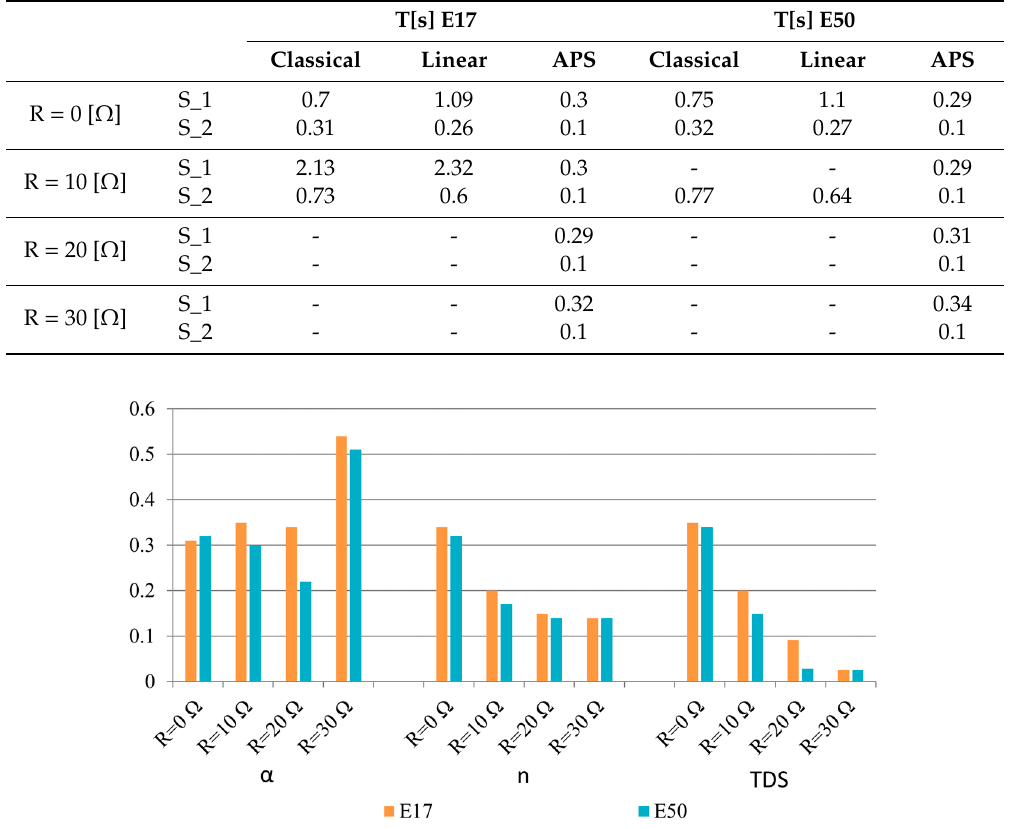
Figure 10. Primary smart sensor setting for a single-phase-to-ground fault under different DG Primary smart sensor setting for a single-phase-to-ground fault under di ff penetrations.